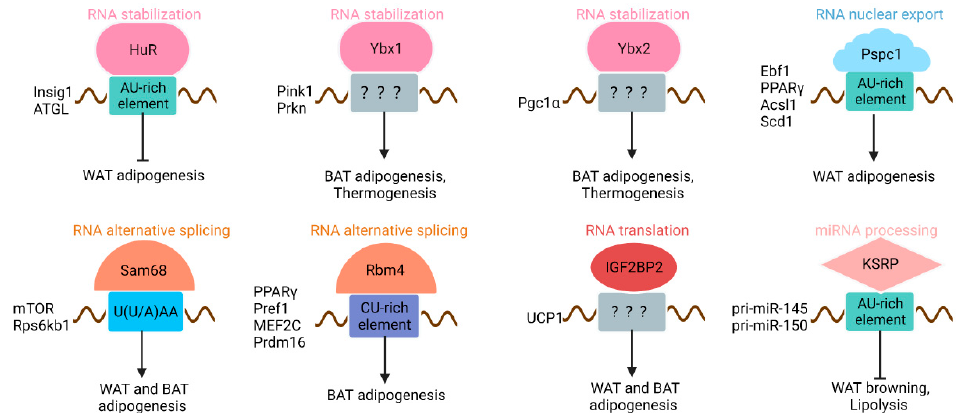
Figure 3. Functions of the selected RNA-binding proteins (RBPs) in adipose tissue. The RNA targets and the cis elements bound by RBPs are shown. The shape of RBP indicates a specific effect on RNA targets.